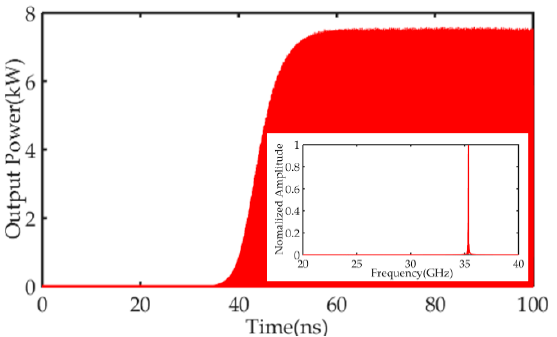
Figure 3. The output power of device-0 with operating voltage of 18 kV and frequency spectrum at a point of the electric field in the output waveguide.